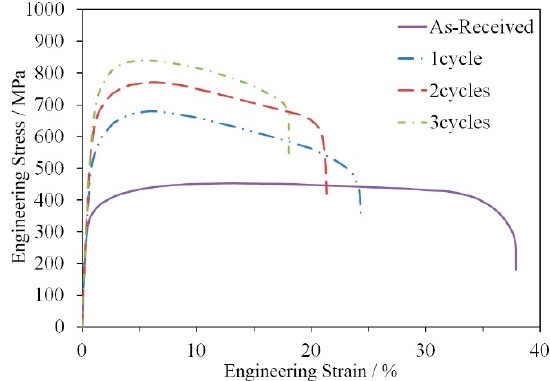
Figure 7. Engineering stress-strain curves of as-received and MDF CP Ti.